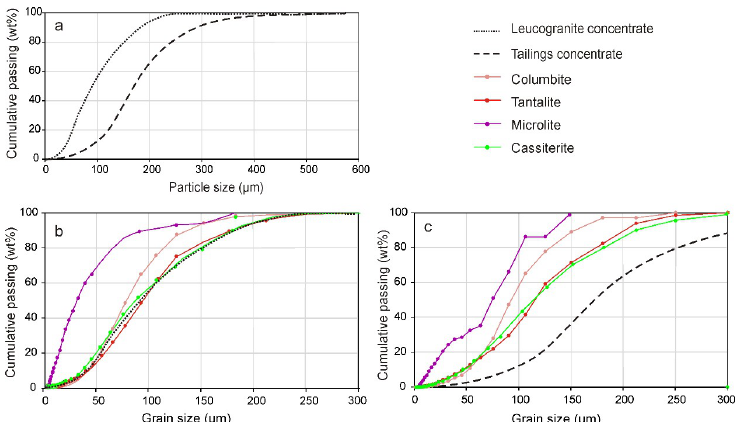
Figure 11. Size distribution determined by mineral liberation analysis (MLA). ( a ) Particle size distribution of ores from concentrates of leucogranite and tailings; ( b ) grain sizes of ore minerals from the Penouta leucogranite; and ( c ) grain sizes of ore minerals from the Penouta tailings.